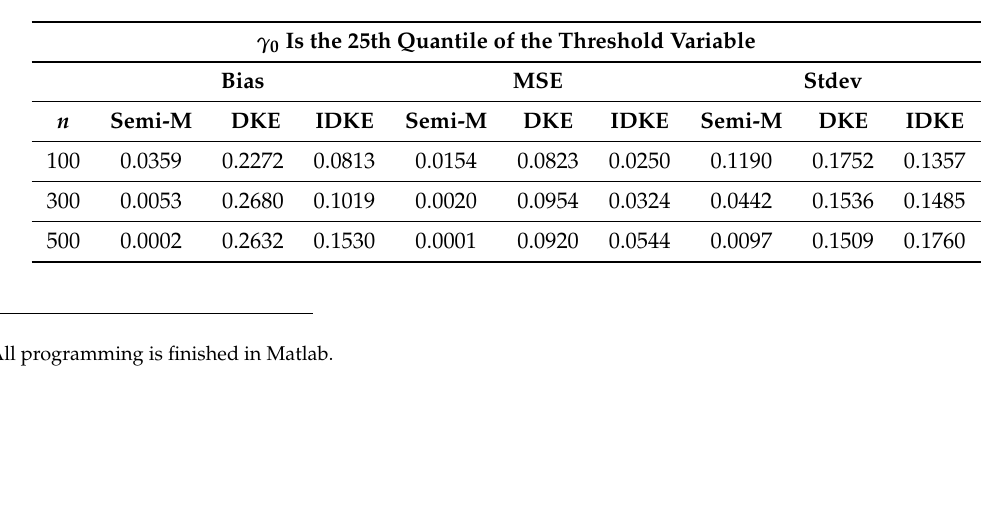
Table 2. Simulation results of nonparametric threshold estimators, DGP